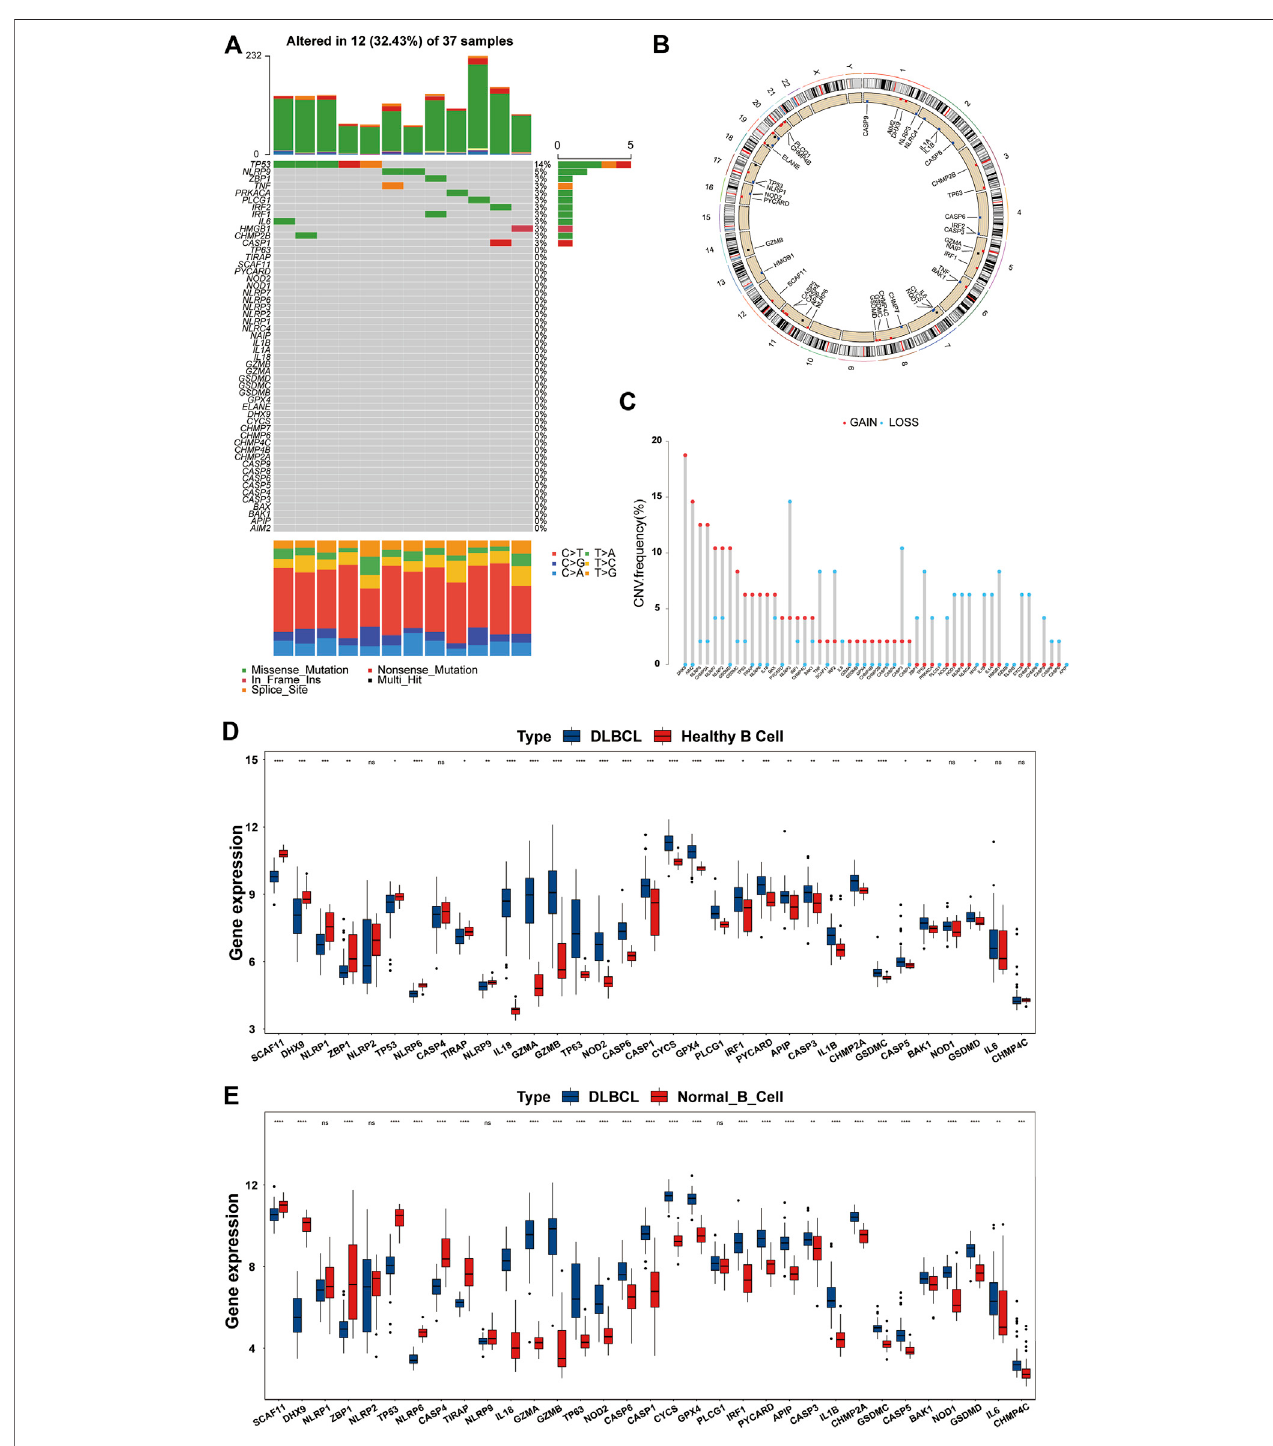
FIGURE 2 | Overview of genetic and expression variation of PRGs in DLBCL. (A) The mutation frequency of PRGs in DLBCL patients from the TCGA-DLBC dataset. Each column represents a patient, and each row represents a PRG. Numbers on the right represent frequencies. Different colors in the bottom annotation representdifferentmutationtypes. (B) TheCNVfrequencyofPRGsinDLBCLpatients fromtheTCGA-DLBC dataset. Thereddotrepresentsampli fi cation,and theblue dotrepresentsdeletion.Thecorrespondingheightofthecolumnrepresentsthefrequency. (C) ThelocationofPRGswithCNVinformationonchromosomes. (D,E) Differentially expressed PRGs in normal B cells and DLBCL from the GSE12195 and GSE56315 datasets. DLBCL sample, blue box; normal B cell sample, red box. ns, not statistically signi fi cant; * p < 0.05; ** p < 0.01; *** p < 0.001; **** p < 0.0001 (all signi fi cance designations that appear in this paper are minor criteria).